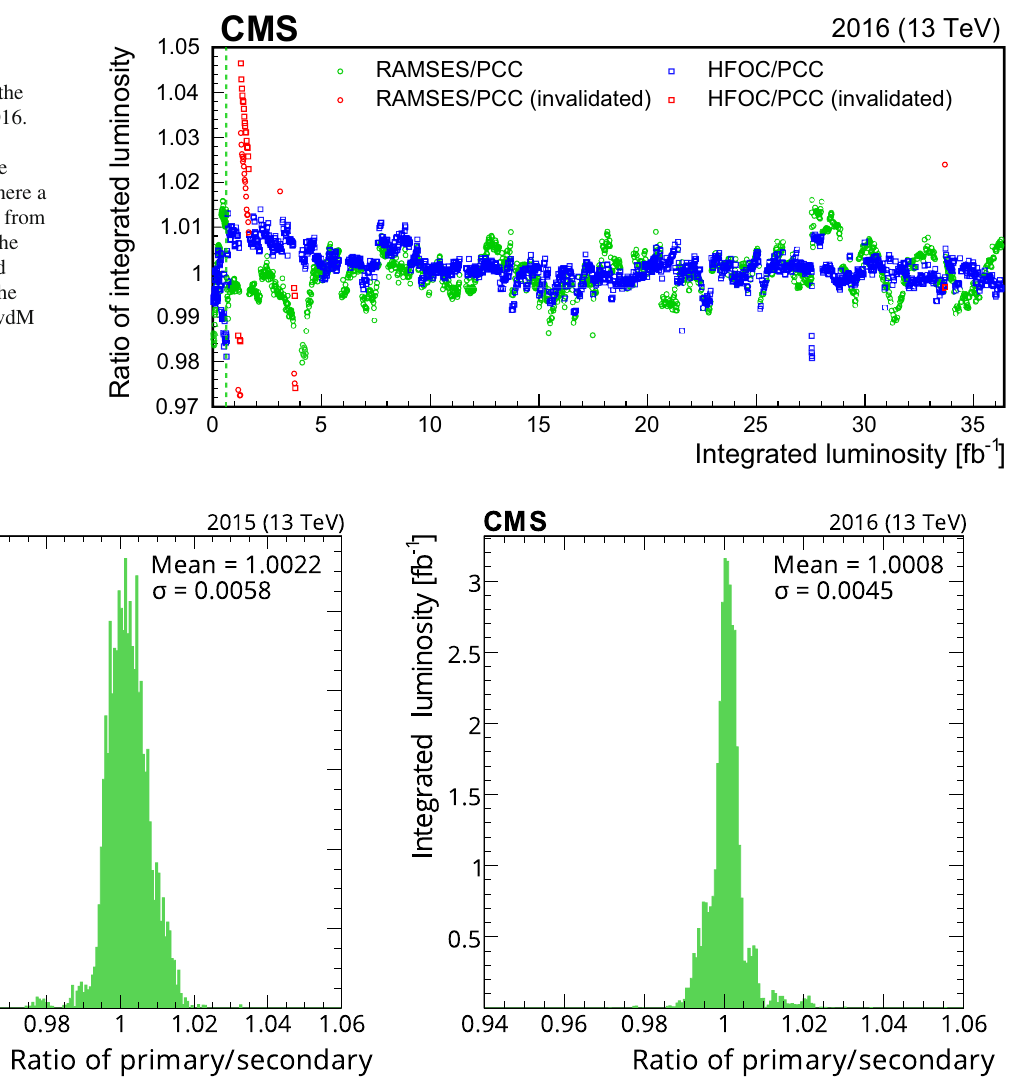
Fig. 18 The ratio of the primary (best available) to secondary (next- best available) luminosity as computed in time windows of approxi- mately 20 min each. The left plot shows the 2015 results (principally